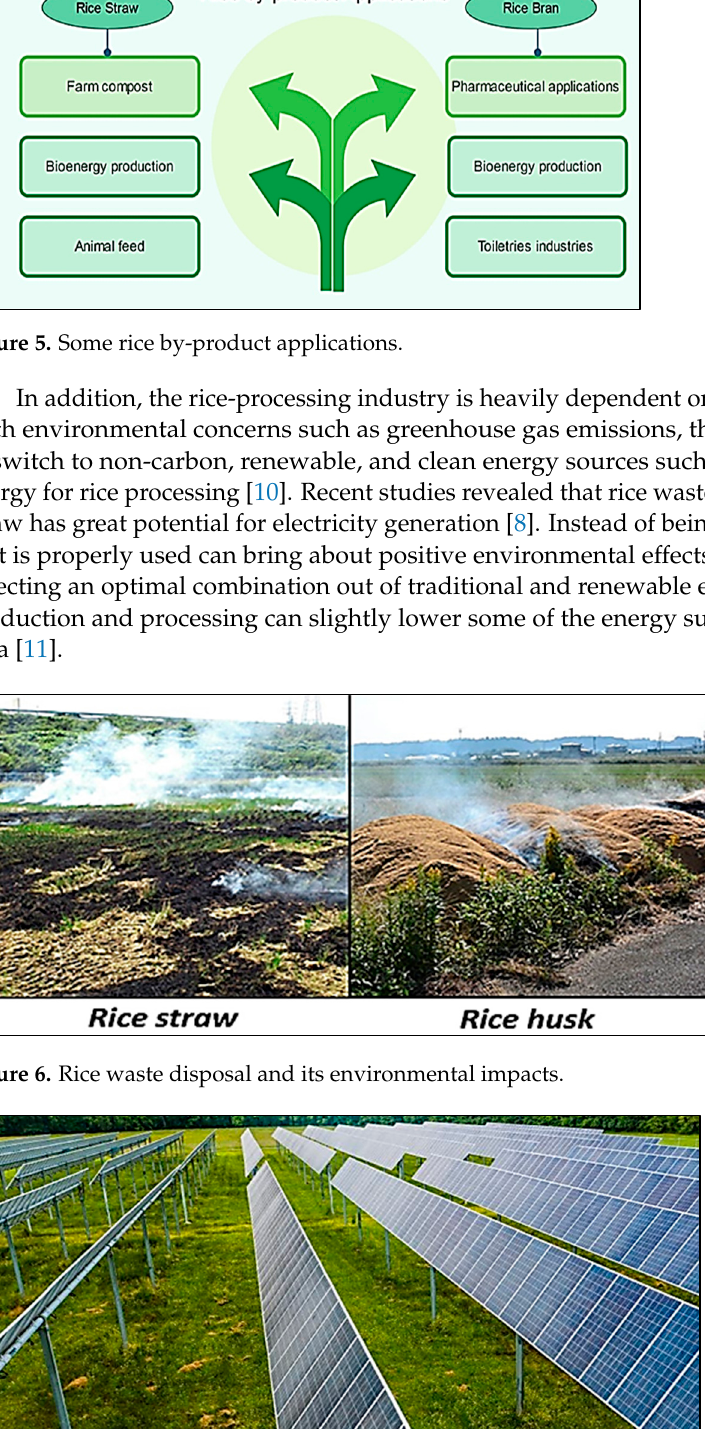
Figure 4. Paddy rice and its components.